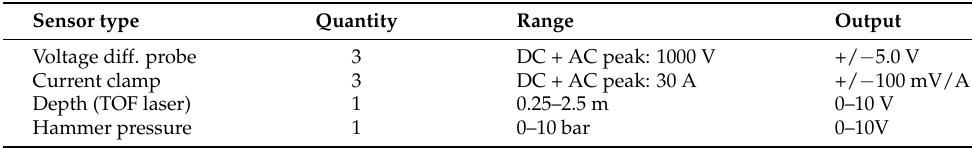
Figure 2. Schematic diagram of the proposed observer-based MWD system. Table 2. MWD sensor specifications.